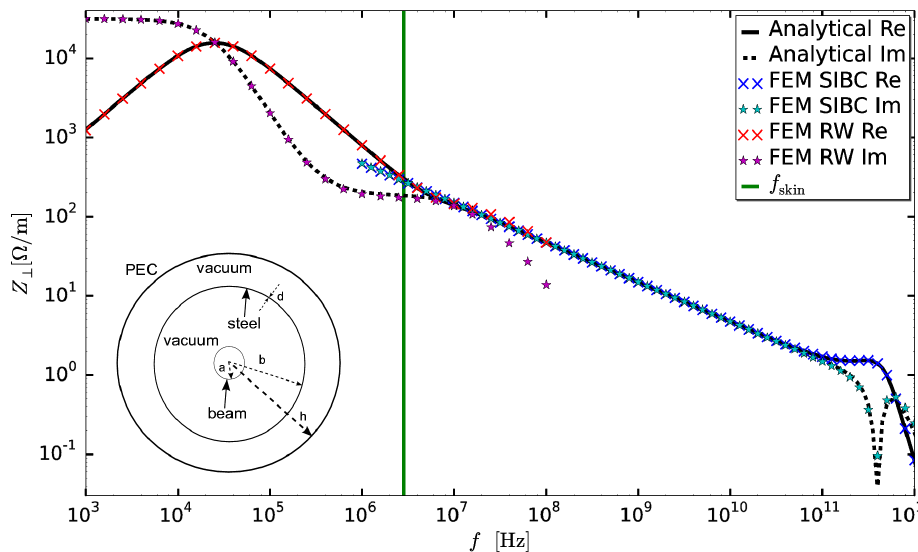
FIG. 7. Transverse impedance of a resistive pipe for β ¼ 0 . 999999 (beam radius a ¼ 1 cm, pipe radius b ¼ 4 cm, thickness d ¼ 0 . 3 mm, h ¼ 1 m, l ¼ 1 m, conductivity κ ¼ 10 6 S =